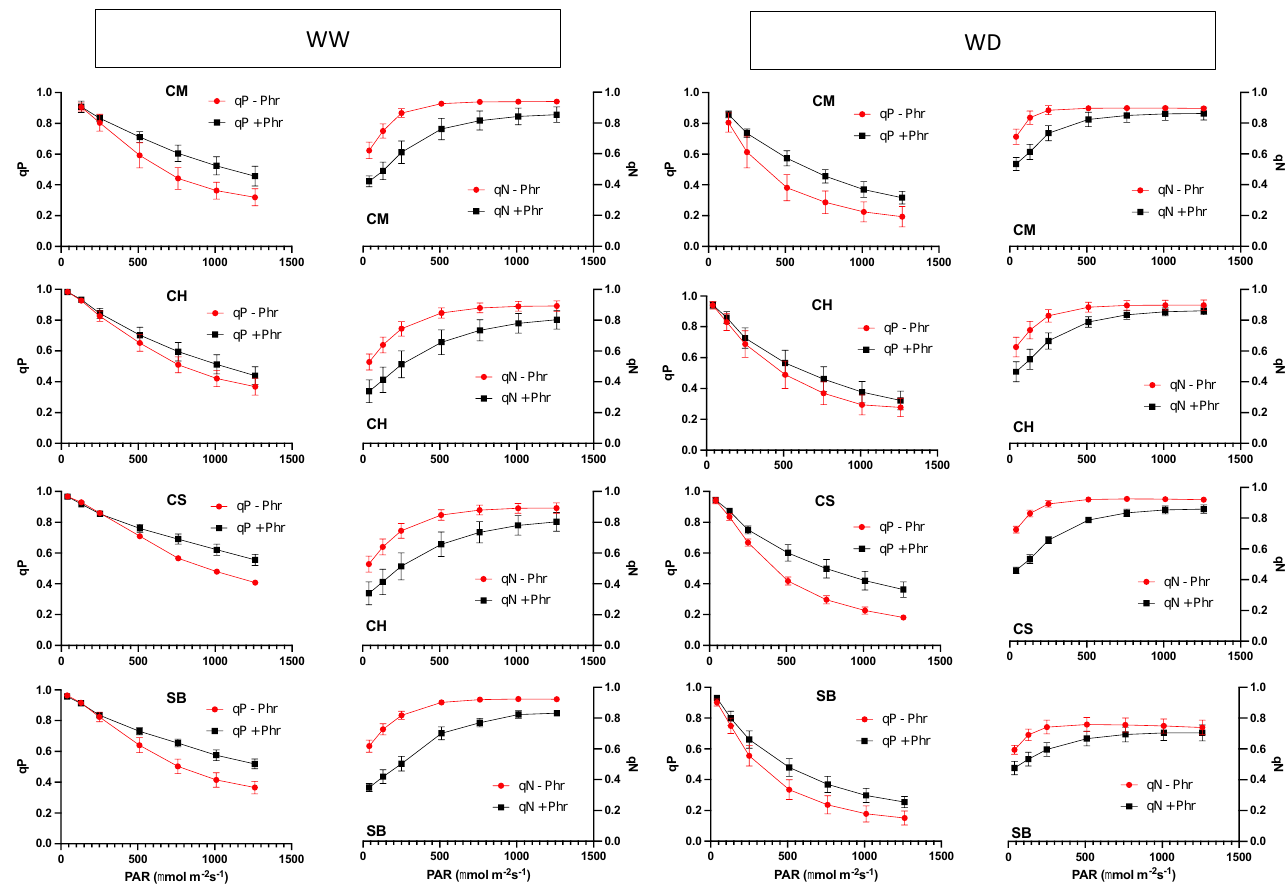
Figure 7. In the case of CM and CH, no significant differences were observed between irrigation treat- Figure 7. Photochemical (qP) and non-photochemical (qN) quenching responses of WW plants (two ments. In CS, differences were significant at light intensities of 750 μ mol photons m −2 s −1 and higher, and panels to the left) and WD plants (two panels to the right) to light intensity in photorespiratory in SB WW and WD the ratio was significantly different at light intensities of μ mol photons m −2 s −1 and conditions (+Phr: squares, black colour) and non-photorespiratory conditions (-Phr: circles, red higher, in both cases with higher values in WD plants (Figure 8). Differences between varieties were colour) in Carmenere (CM), Chardonnay (CH), Cabernet sauvignon (CS) and Sauvignon blanc (SB). significant, as well as between irrigation treatments, but with no interaction between both factors (Table Error bars represent 2).